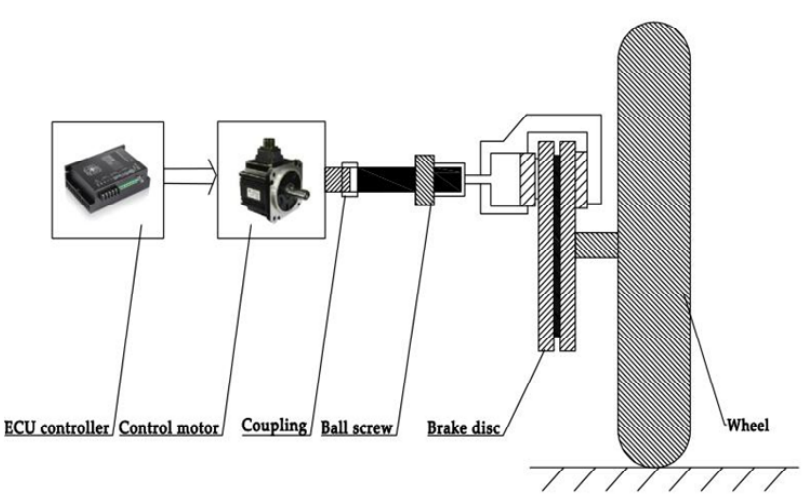
Figure 1. The control structure of the EMB system.